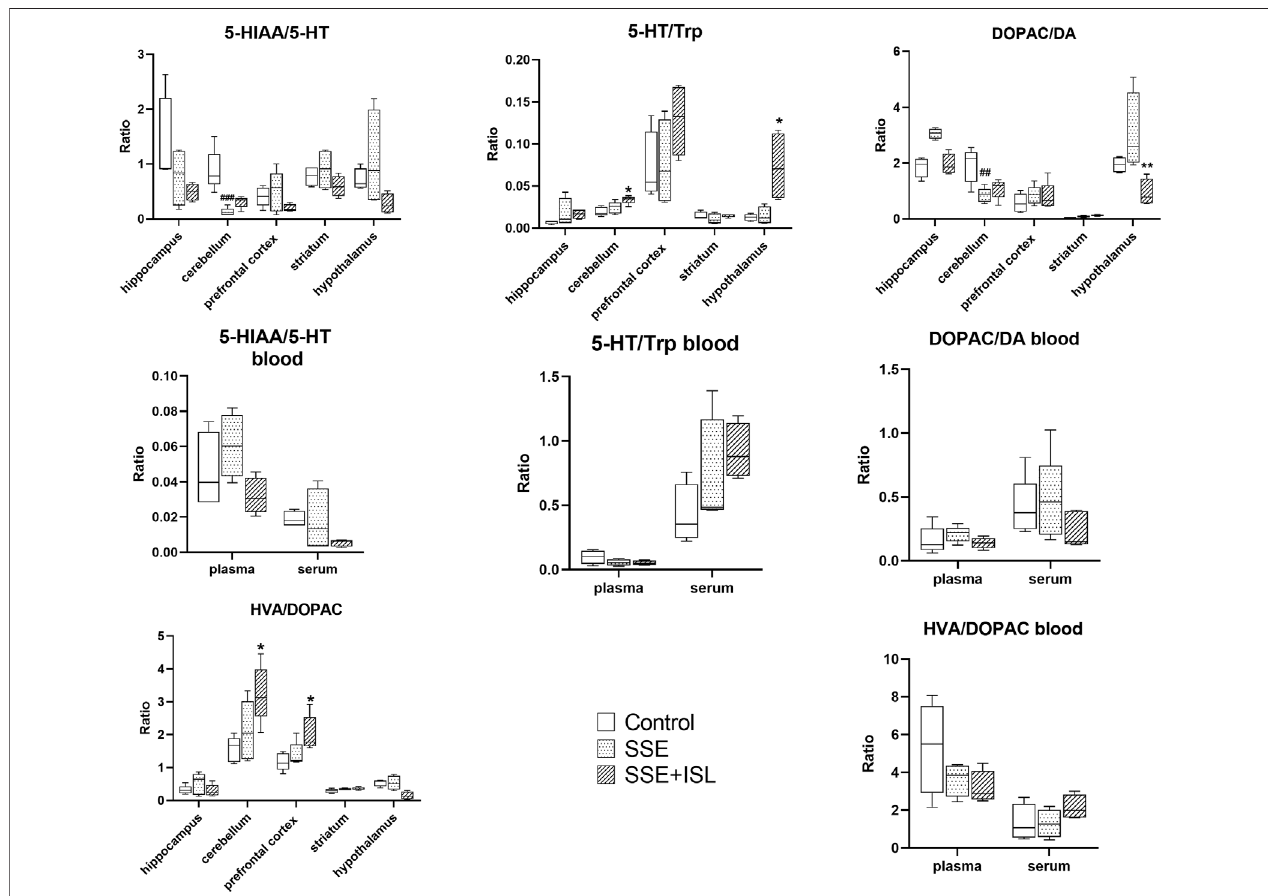
FIGURE 5 | The ratios of product/neuroactive precursor in blood and brain samples. Each value was represented as mean ± SD (standard deviation). ### p < 0.001, ## p < 0.01, and # p < 0.05 (SSE group vs. Control group); *** p < 0.001, ** p < 0.01, and * p < 0.05 (SSE + ISL group vs. SSE group)